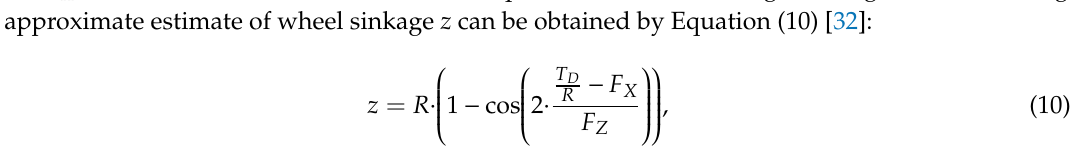
Table 3 sums up the proprioceptive feature space spanned by the above considerations. Table 3. Proprioceptive features with relative feature ID number and